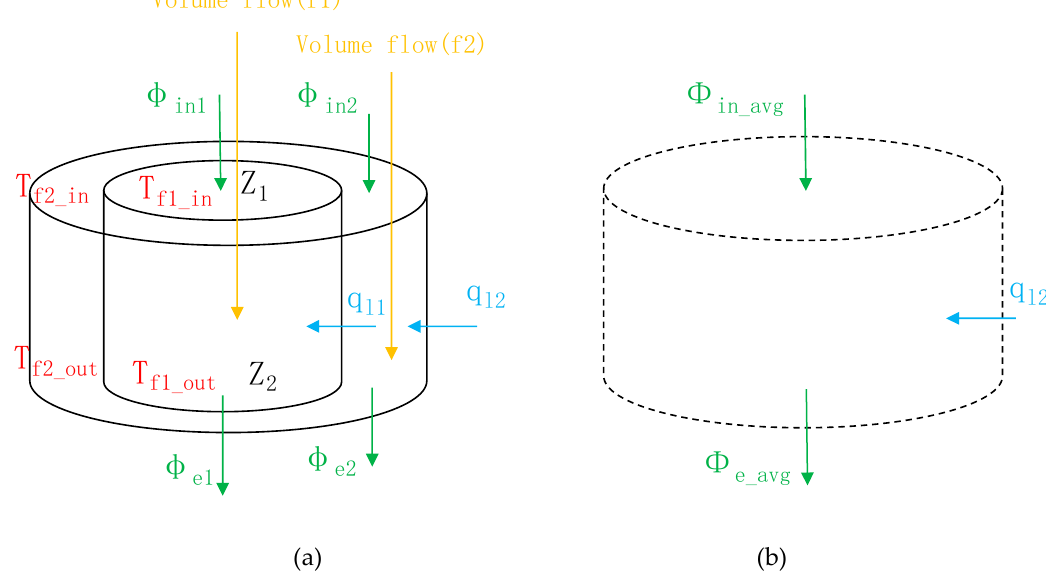
Figure 5. The basic schematic of energy balance method and equivalent fluid domain. ( a ) is the volume and heat transfer in real dual-tubing system, ( b ) is the volume and heat transfer in simplified system.